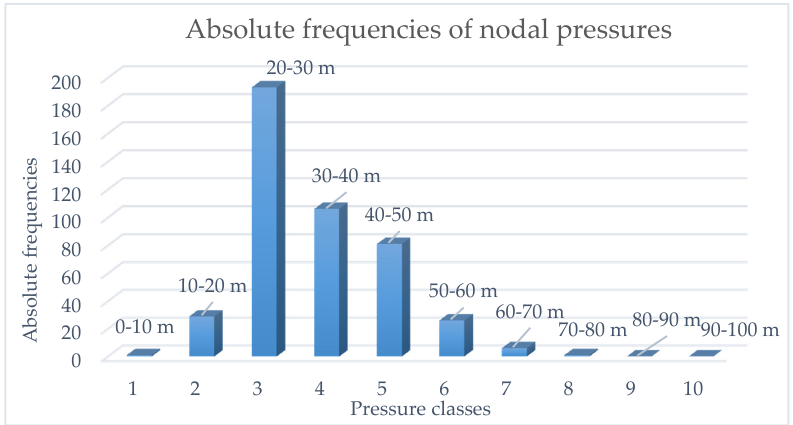
Figure 10. Histogram of absolute frequencies of nodal pressures of BIN solution 1.